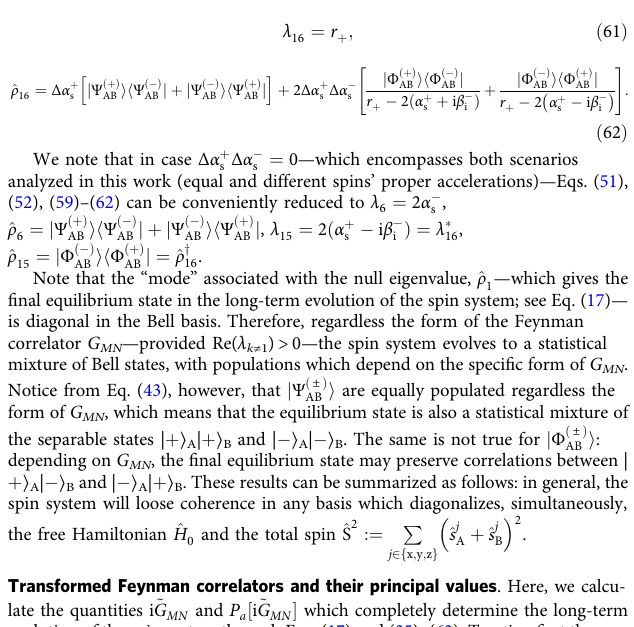
ffiffiffiffiffiffiffiffiffiffiffiffiffiffiffiffiffiffiffiffiffiffiffiffiffiffiffiffiffiffi p ð α (cid:2) s Þ 2 þ 4 α þ i ð α þ i þ α (cid:2) i Þ